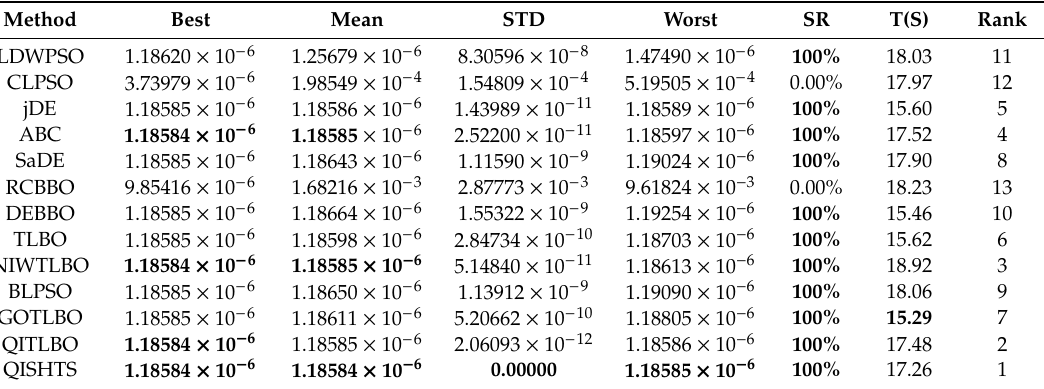
Table 7. Results of the compared algorithms for the first-order reversible series reaction model. Best: the best objective function value, Mean: the mean objective function value, STD: the standard deviation, Worst: the worst objective function value, SR: success rate, and T(S): time